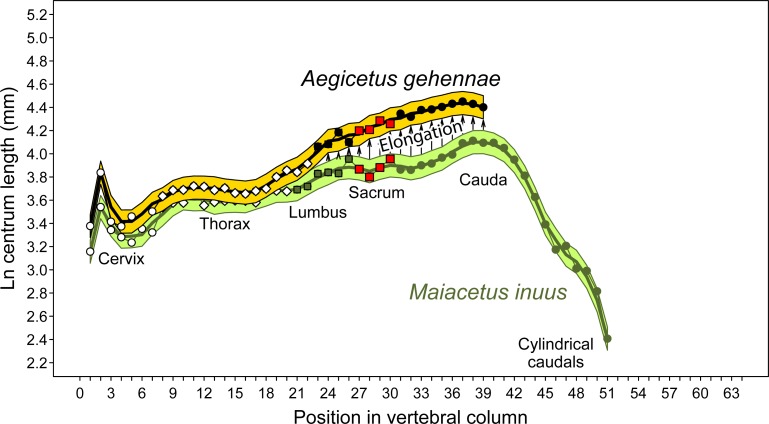
Vertebral length profile for late Eocene Aegicetus gehennae type specimen (CGM 60584; gold) compared to that for early middle Eocene Maiacetus inuus (GSP-UM 3551; green).Vertical axis is proportional, with the natural logarithm of centrum length plotted on the ordinate. Colored bands are inferred 95% confidence intervals for centrum length (3-point running average). Aegicetus gehennae is larger. In addition, note that posterior lumbar, sacral, and anterior caudal vertebrae are disproportionately elongated relative to expectation based on the overlap of cervical and thoracic color bands. Posterior caudal vertebrae have not been found for A. gehennae so it is not known whether they were cylindrical like those of M. inuus or dorsoventrally flattened like those of contemporary basilosaurids. Symbols: open circles, cervical vertebrae; open diamonds, thoracics; solid squares, lumbars; red squares, sacrals or vertebrae homologous with sacrals; solid circles, caudals.